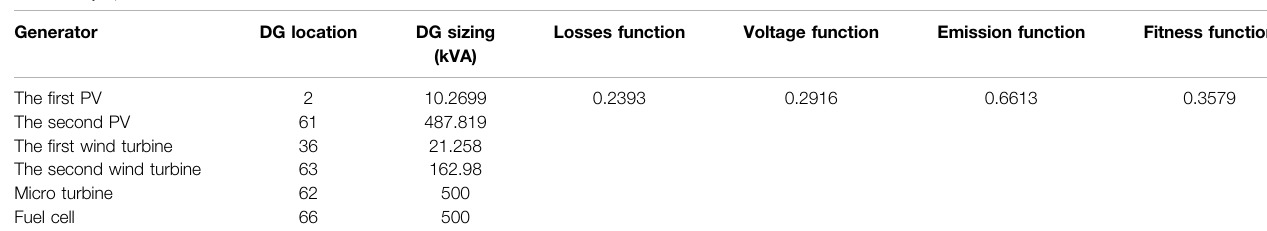
TABLE 3 | Optimization results of